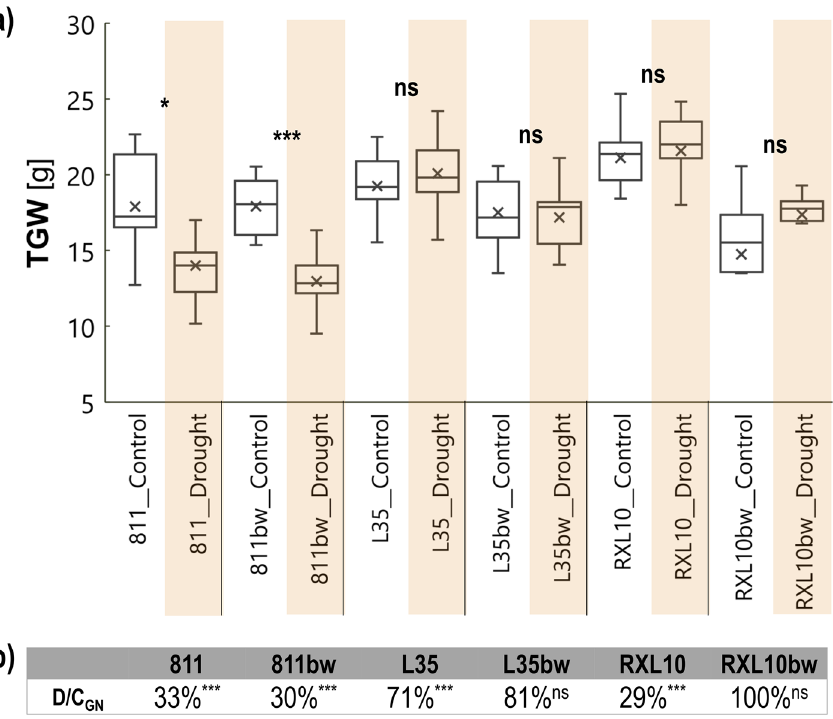
Figure 7. Box plot ( a ) of leaf thousand grain weight (TGW) by glaucous (811, L35, RXL10) and non-glaucous (811bw, L35bw, RXL10bw) near-isogenic lines of rye and by soil water status (control or drought) and the drought to control percentage ratio ( b ) of grain number (D/C GN ) in glaucous (811, L35, RXL10) and non- glaucous (811bw, L35bw, RXL10bw) near-isogenic rye lines. The statistically significant differences between the means in control and drought were verified for P ≤ 0.001(***), P ≤ 0.01(**), P ≤ 0.05(*) according to Student’s test. Ns not